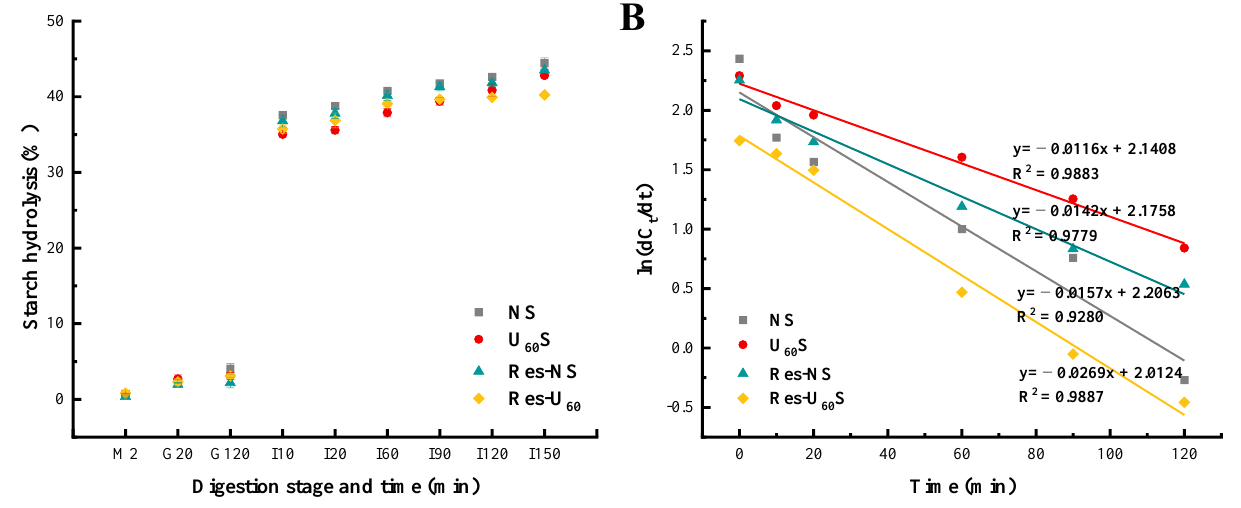
Figure 4. ( A ) Changes in starch hydrolysis (%) of different samples in in vitro starch digestion. Error bars represent standard deviation (n = 3). Key: M = simulated mouth-digestion stage, G = simulated gastric-digestion stage, and I = simulated small-intestinal-digestion stage. The numbers following M, G, and I represent the digestion time in minutes for each stage. ( B ) LOS plots of samples.